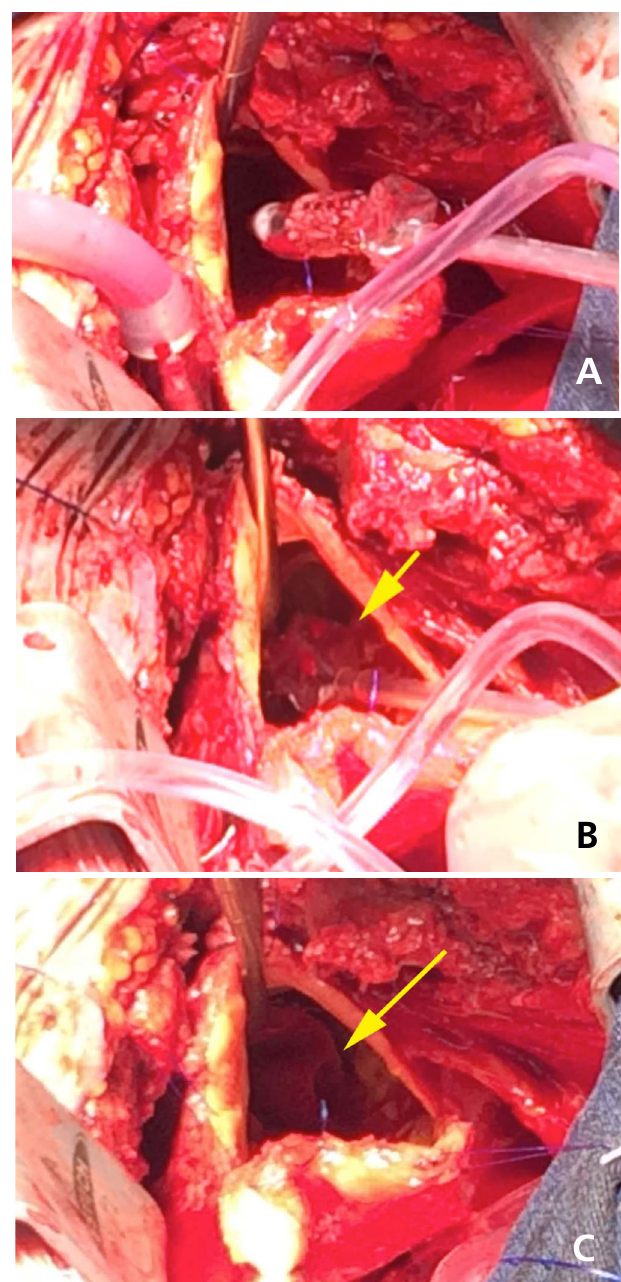
Fig. 2 - The deployment of the Inovare-Alpha in the experimental setting.